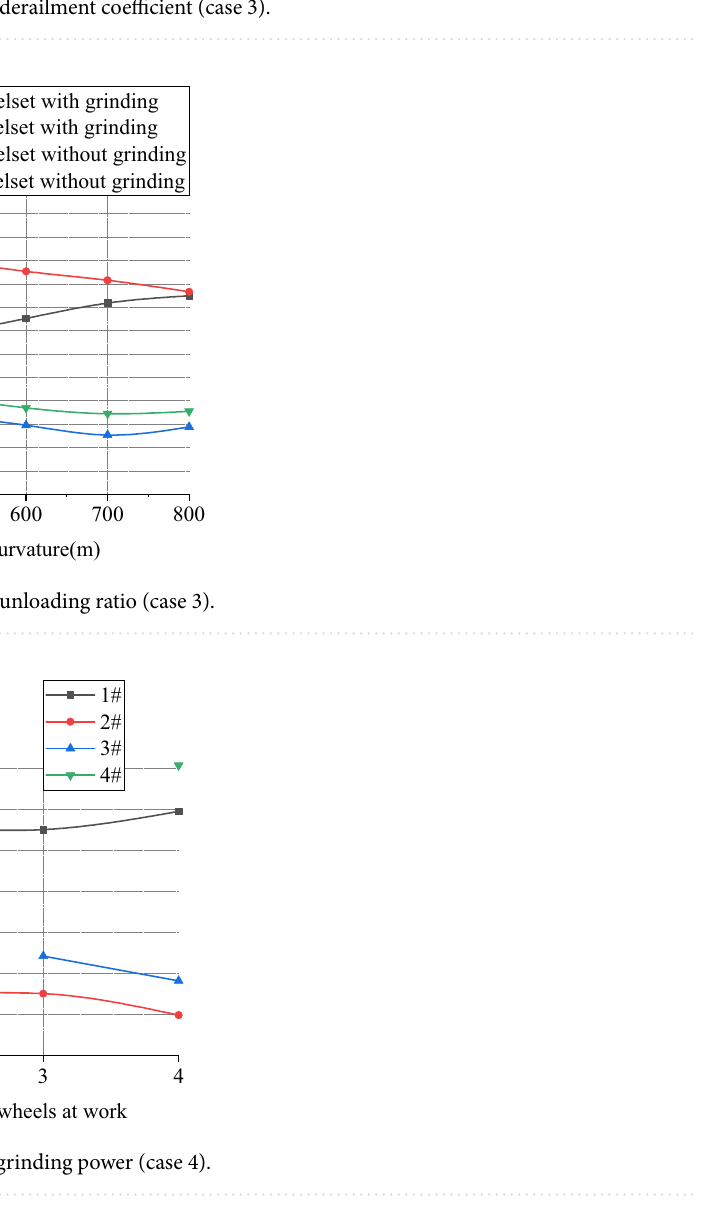
Figure 28. Curvature radius and derailment coefficient (case 3).